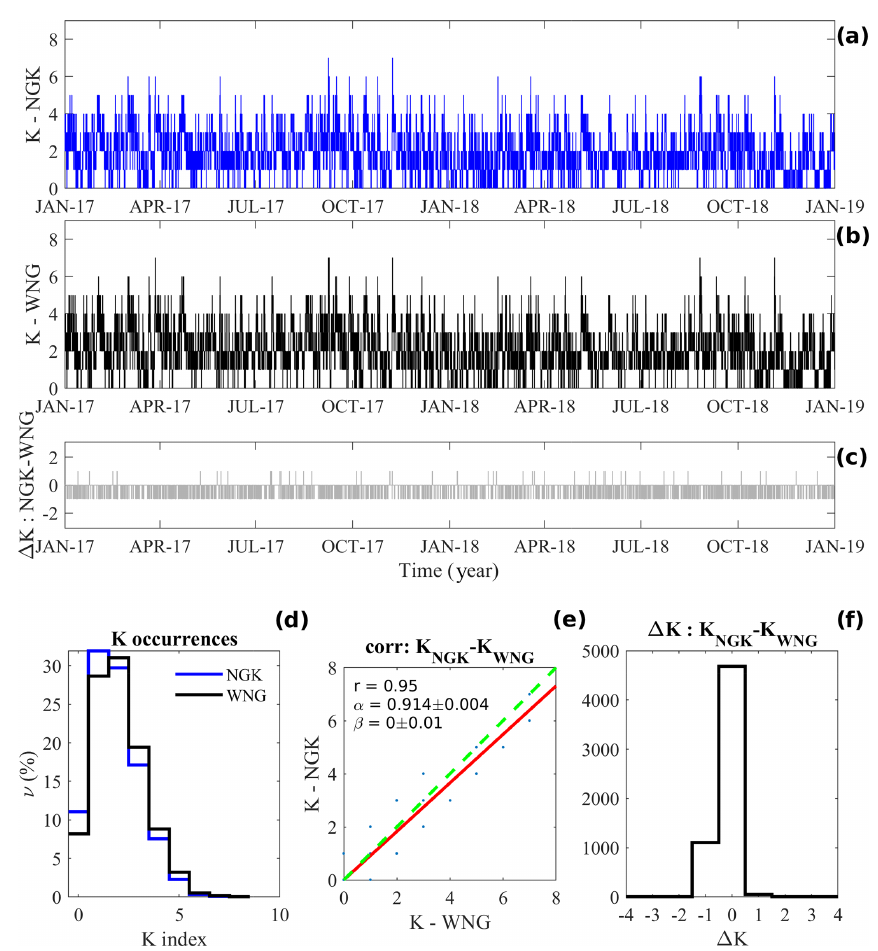
Figure 2. (a, b, c) K indices at NGK (a) and WNG (b) ; (cid:49) K = K NGK − K WNG (c) . Occurrences of K indices at both observatories (d) . Linear regression analysis of K NGK = α K WNG + β law (red line), by assuming β = 0, and correlation coefficient r , together with the K NGK = K WNG condition (green line) (e) . The (cid:49) K distribution (f)